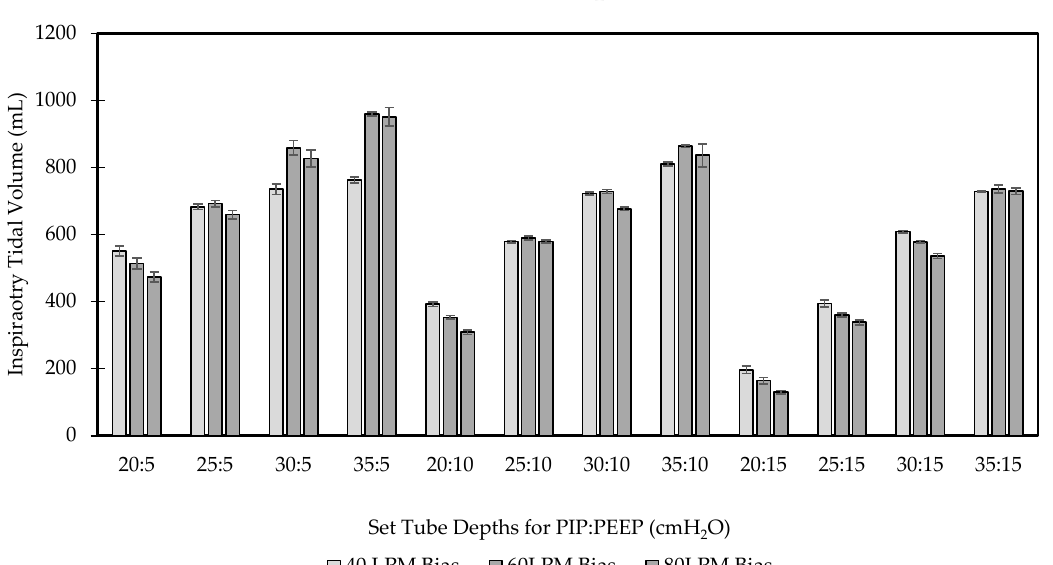
Figure 4. Delivered volumes to the lung model in response to changes in bias flow, PIP, and PEEP. PIP and PEEP are indicated by the numbers just below the horizontal axis. PIP and PEEP are separated by a “:” as, for example, 20:5 is PIP of 20 cmH 2 O and a PEEP of 5 cmH 2 O. Lung model compliance was 55 mL/cmH 2 O, and inspiratory and expiratory resistance was 12 cmH 2 O/L/min. All bars are Mean ± SD.